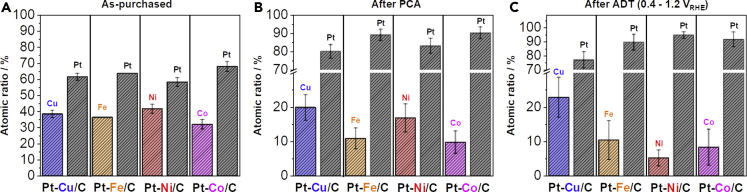
ex-situ EDX-STEM comparison of Pt-M/C FCS electrocatalysts after PCA and after ADTEx-situ EDX-STEM analysis of Pt-M/C electrocatalysts (B) after PCA (200 cycles in 0.1 M HClO4, 0.05–1.2 VRHE, 300 mV s−1, Ar saturated, 600 rpm) and (C) after ADT (5000 cycles in 0.1 M HClO4, 0.4–1.2 VRHE, 1 V s−1, Ar saturated, 600 rpm). A minimum of four large areas containing several hundred nanoparticles were measured each time. For more EDX-STEM of Pt-M/C electrocatalysts see also Supplemental informationFiguresS2–S9. The colors in the bar graphs (Pt = black, Cu = blue, Fe = orange, Ni = red and Co = magenta) correspond to the atomic percentage ratios.